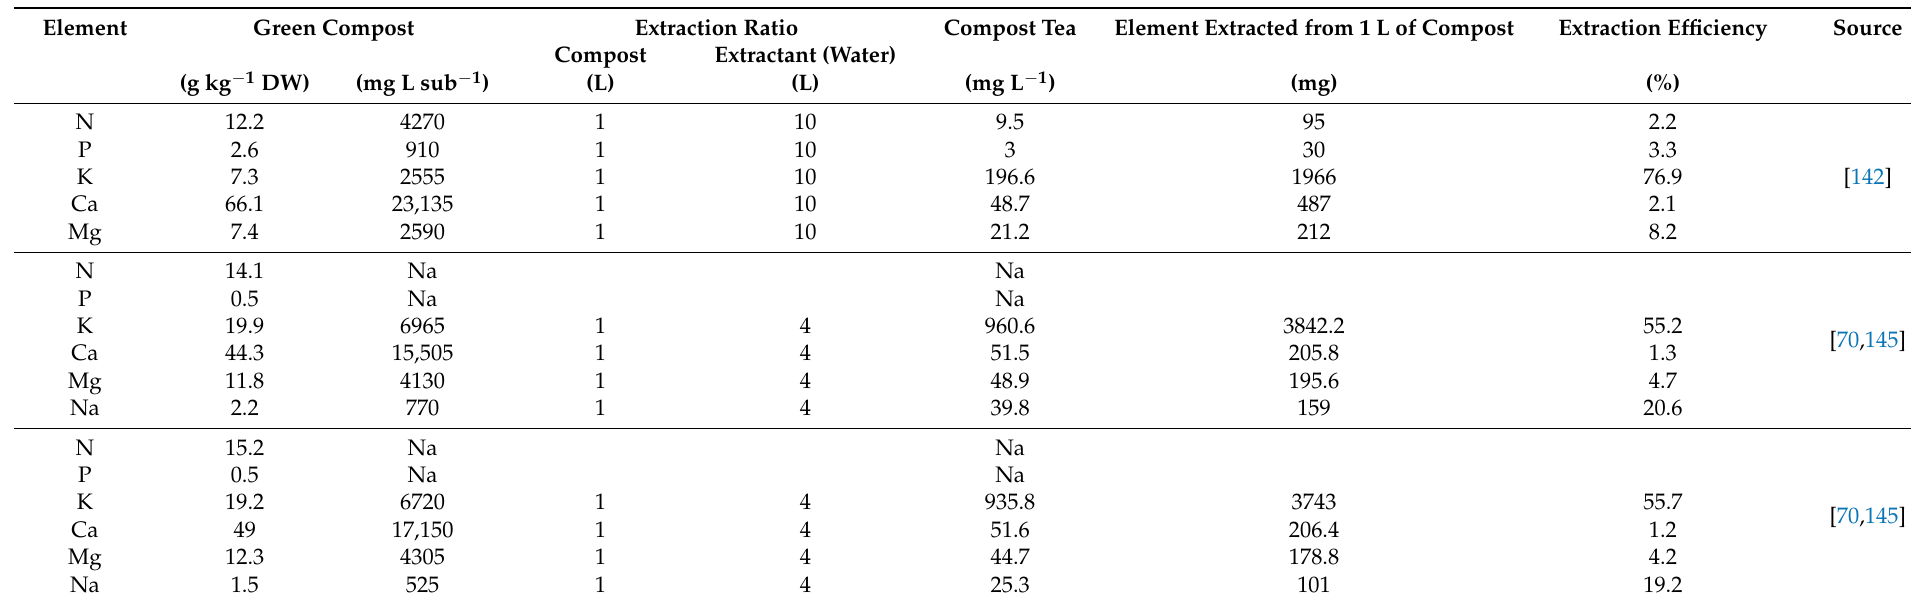
Table 3. Element composition * of green compost (on a dry weight (DW) or substrate volume (Lsub) basis), compost teas, and elements extraction efficiency from green compost to compost teas.